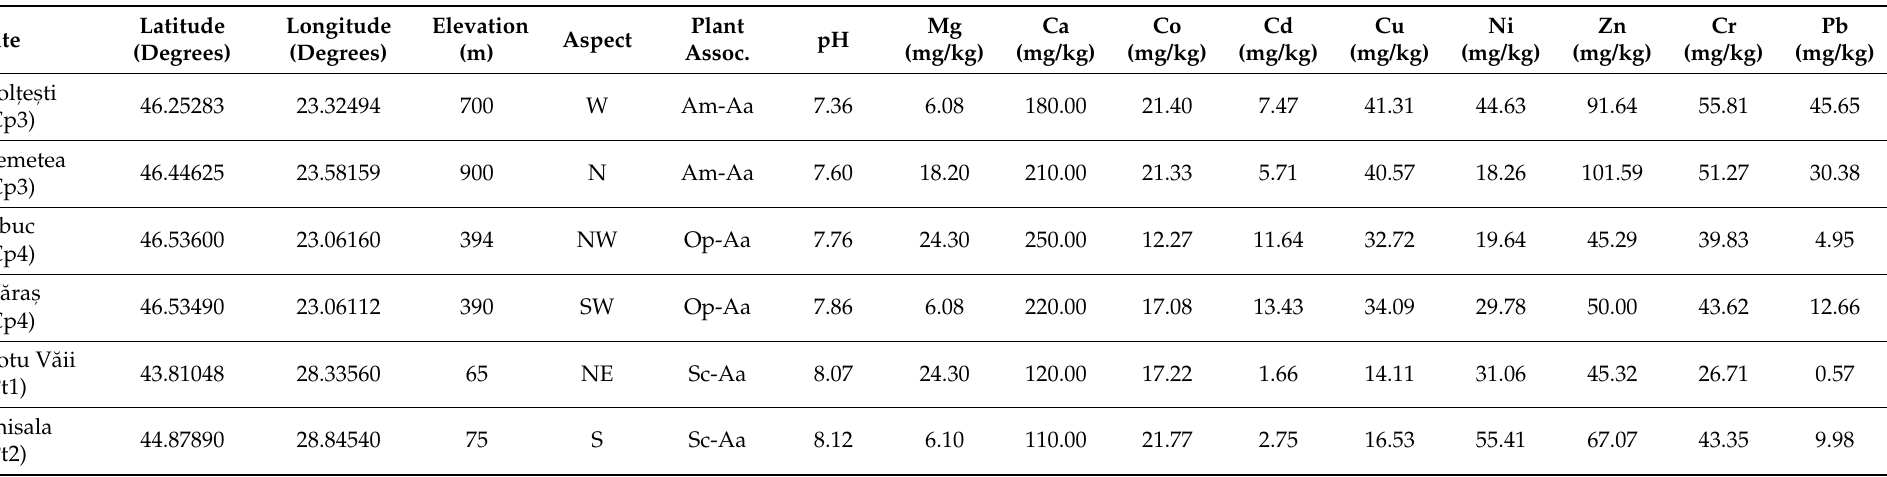
Table 1. Extractable cations content and pH of soil samples collected in the investigated sites in the Carpathian (Cp) and Pontic (Pt) regions in Romania (see also Figure 1). The geo-topographic location and corresponding plant associations are indicated for each soil sample. Abbreviations as in Figure